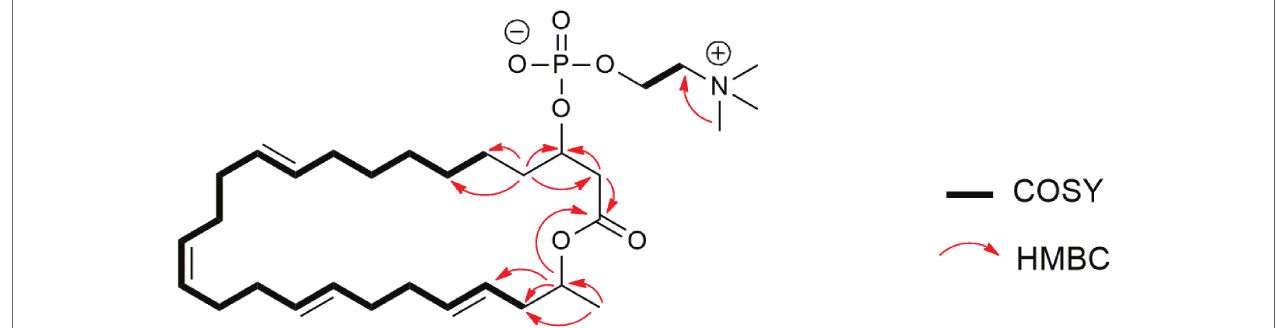
FIGURE 10 | Selected COSY and HMBC correlations of tropicicolide ( 6